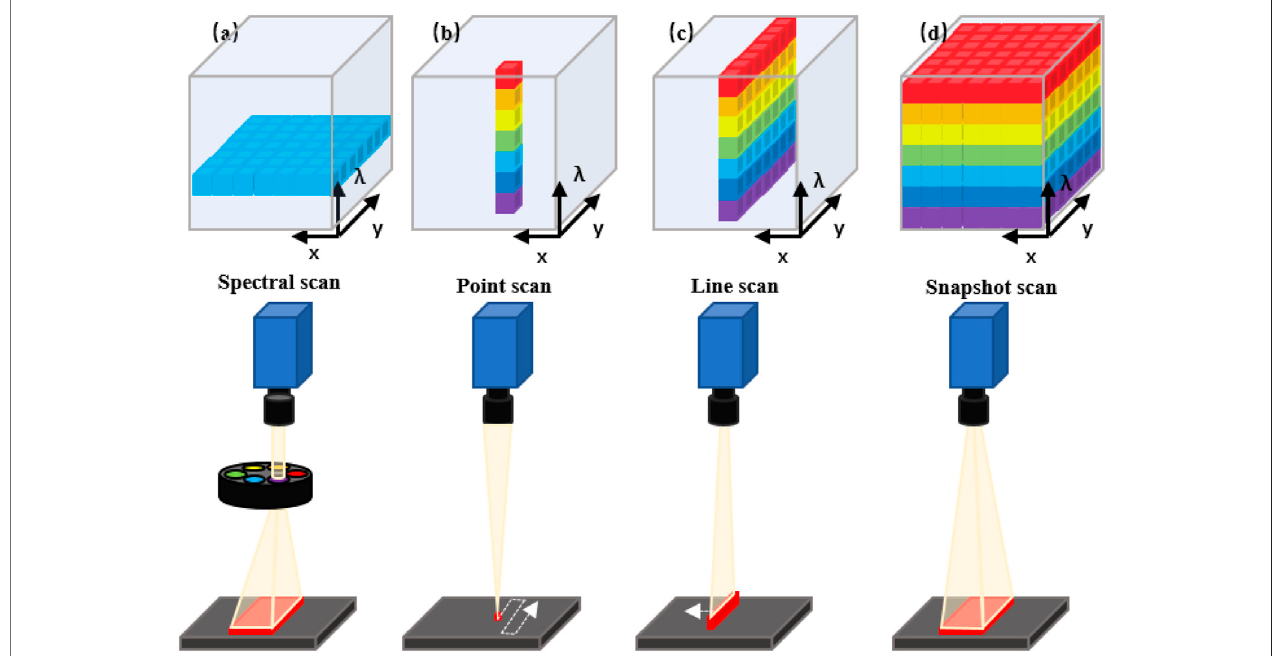
FIGURE1| Schematicdiagram oftheacquisition approachofthehyperspectral datacube. (A) Spectral scanning: onewavelengthbandimage atatime. (B) Point scanning (wiskbroom imaging): one spectrum of only one point in a single measurement. (C) Line scanning (pushbroom imaging): spectra of points on the same linein a single measurement. (D) Snapshot: covering the full spectrum in a single